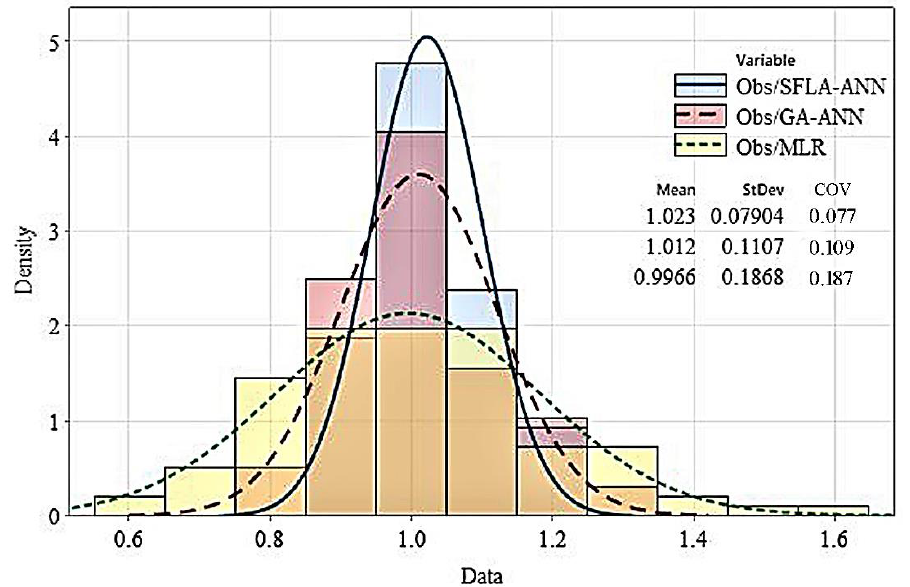
Table 9. Statistics of the developed models.